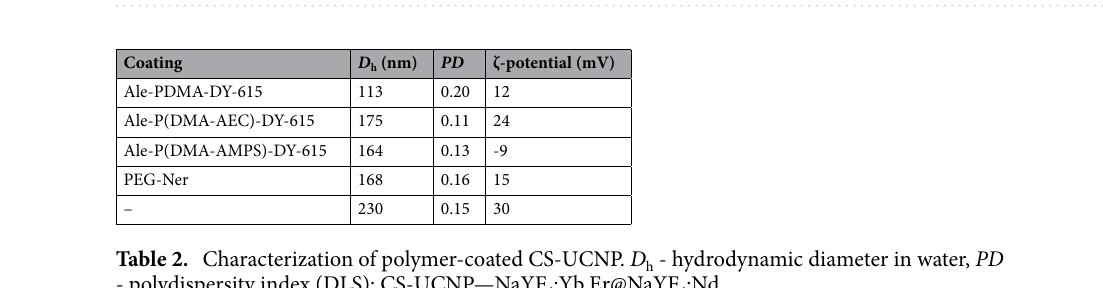
Figure 5. Photoluminescence upconversion spectra of neat C-UCNP and CS-UCNP in ( a ) hexane and water and ( b ) PEG-Ner-, Ale-P(DMA-AEC)-DY-615-, Ale-P(DMA-AMPS)-DY-615-, and Ale-PDMA-Dy-615-coated CS-UCNP particles in water at 808 nm excitation; particle concentration 1 mg/ml; power density 1 W/cm 2 . C-UCNP—NaYF 4 :Yb,Er; CS-UCNP—NaYF 4 :Yb,Er@NaYF 4 :Nd.